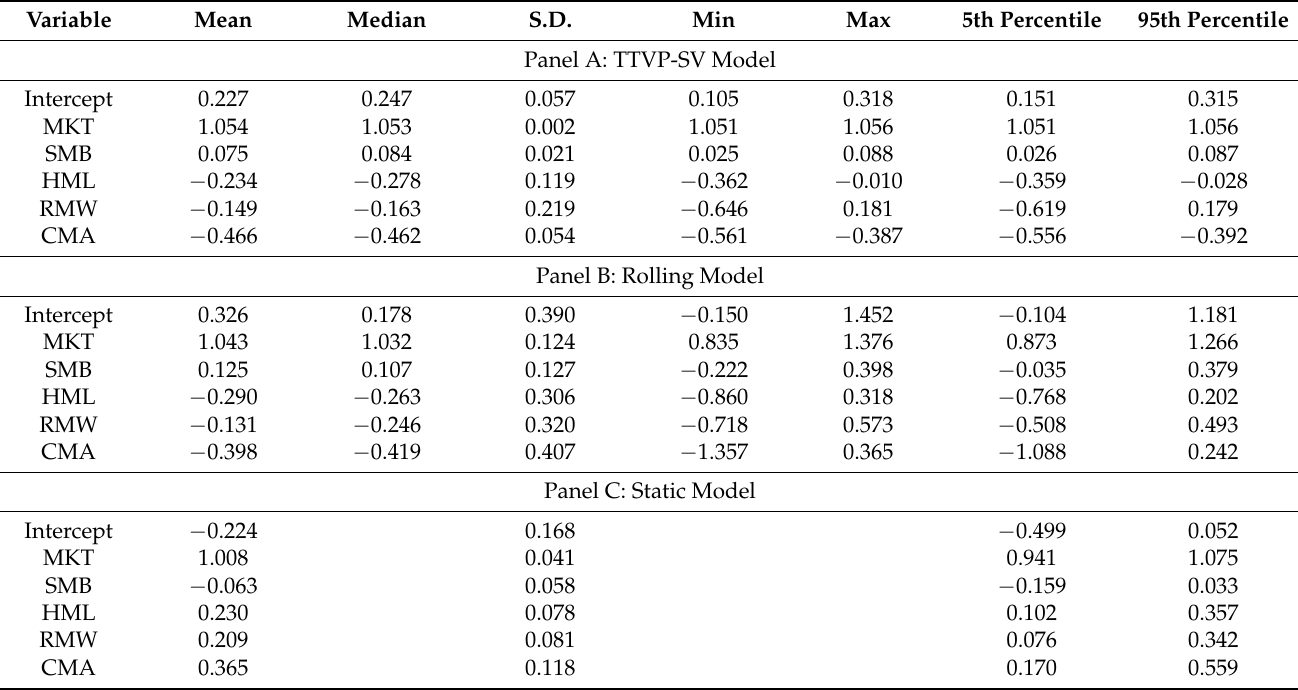
Table 5. Time varying, rolling and static factor betas—High